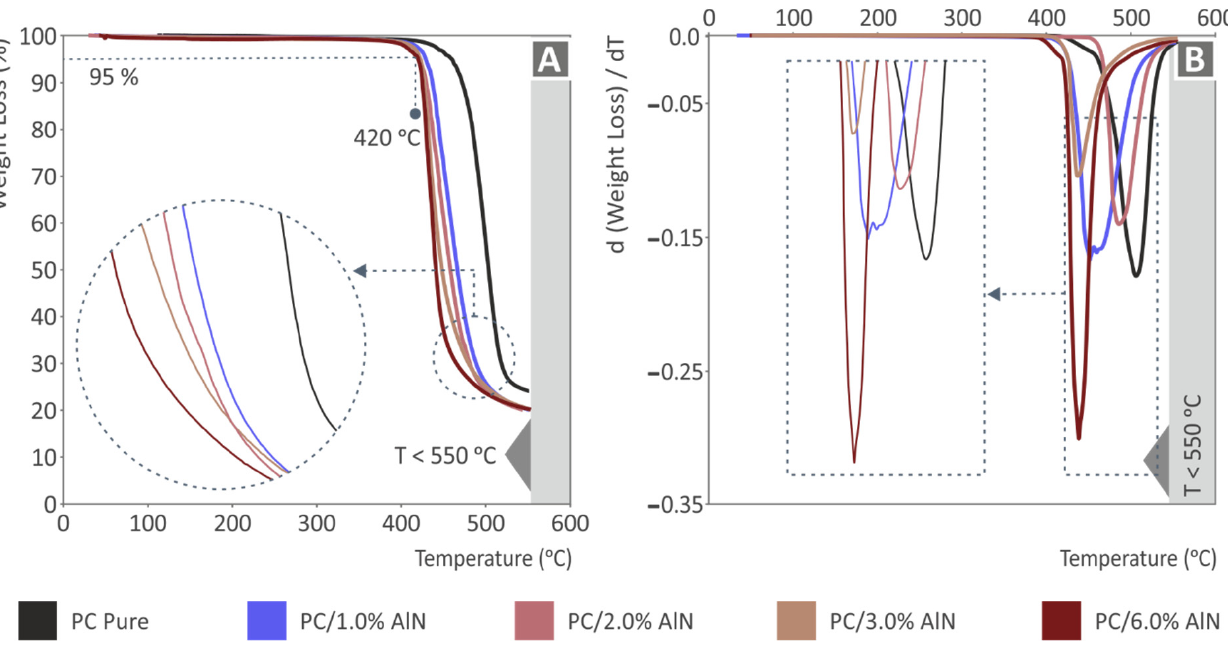
Figure 3. TGA measurements for all PC/AlN nanocomposites and pure PC: ( A ) weight loss and ( B ) its derivative dw/dT as a function of temperature.